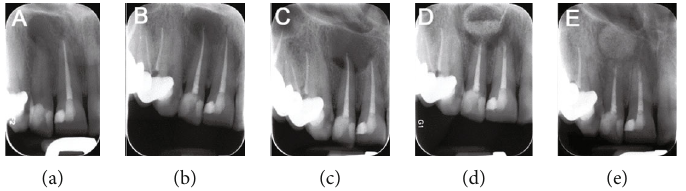
Figure 1: Periapical radiographs: (a) preoperative image of teeth #12, showing a large endodontic lesion; (b) immediate postendodontic radiograph; (c) at two-month follow-up, the patient returned with abscess formation and a larger periapical lesion; (d) applying bone substitute material during surgical retreatment; (e) at 6-month follow-up, bone healing can be observed.